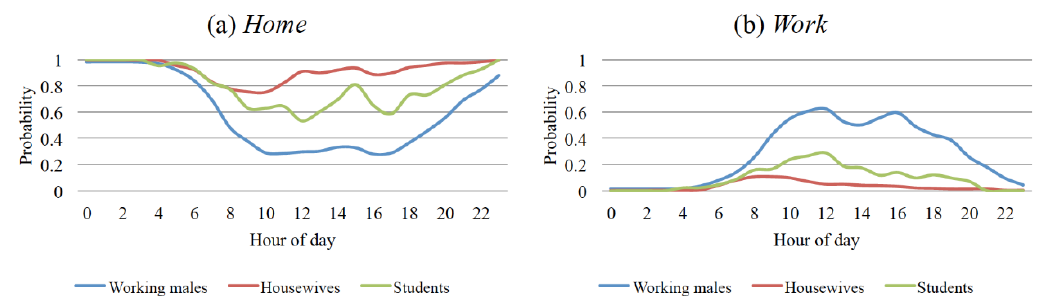
Figure 1. Hourly probability distribution of being at ( a ) home and ( b ) work for three principal population groups.